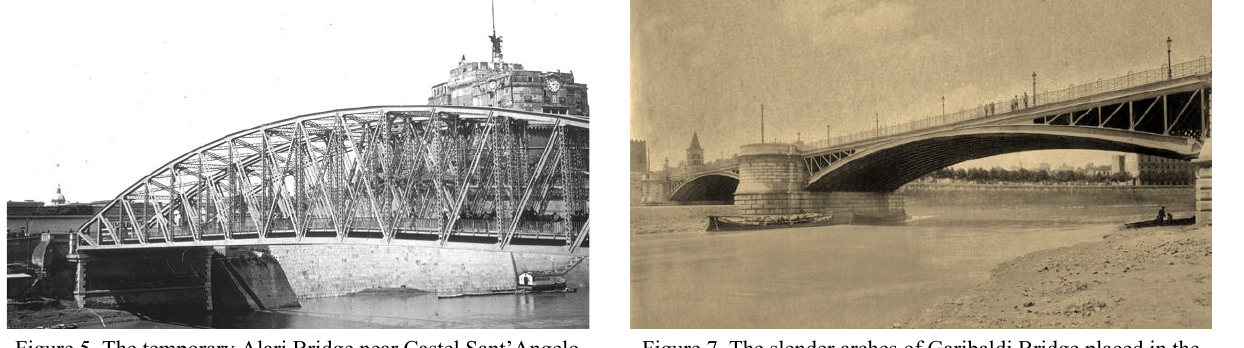
Figure 7. The slender arches of Garibaldi Bridge placed in the north side of Tiber Island (Vannelli, 1979)